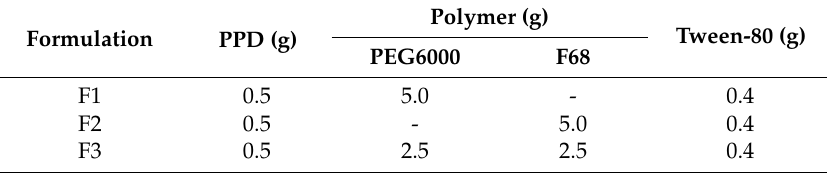
Table 1. SD formulation ratio ( m / m ) of PPD with different